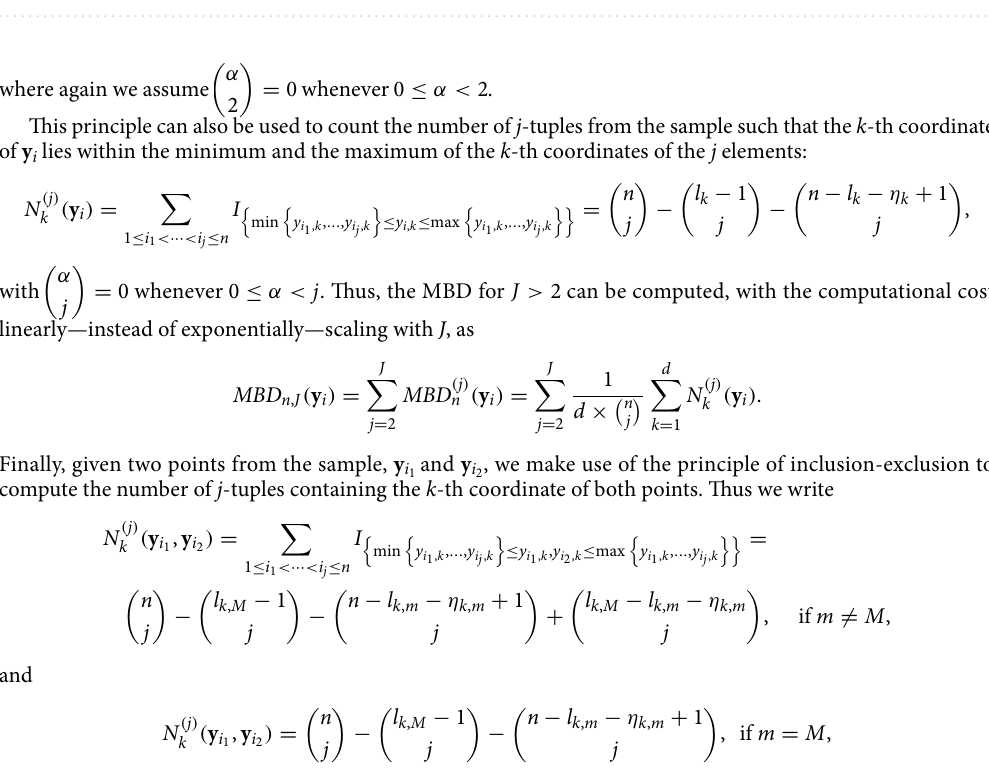
Figure 2. Method workflow. Calculations relative to red blocks can be skipped to alleviate the computational